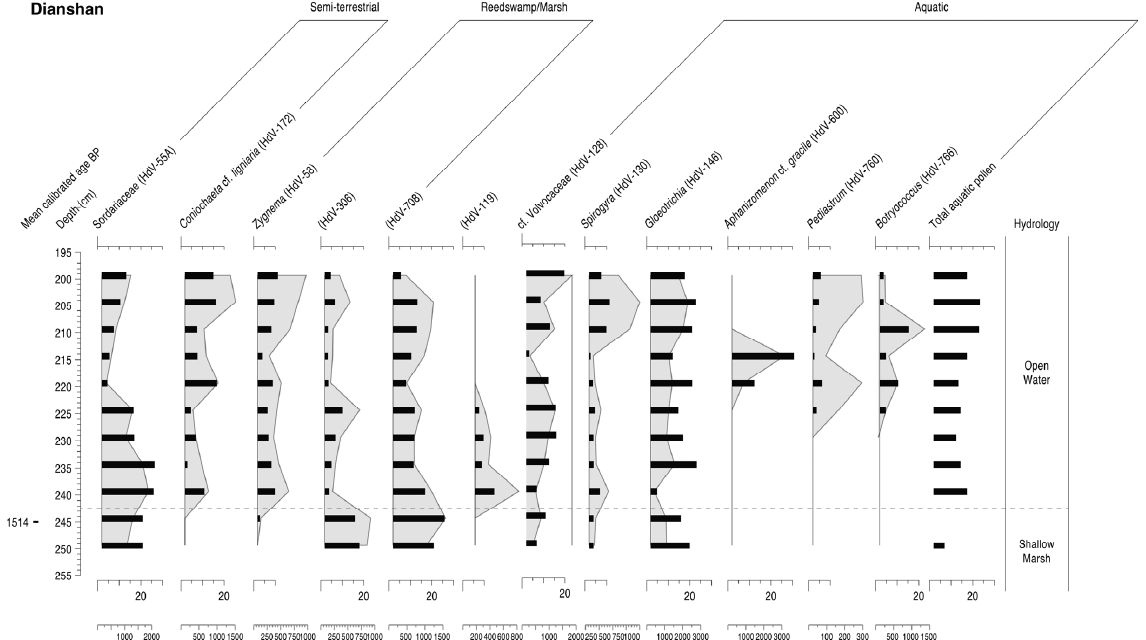
Figure 4. Frequencies of selected NPP taxa (histogram bars calculated as % total NPPs) from Dianshan. A combined aquatic pollen curve is also shown, calculated as percentages of total land pollen. Pollen concentration values for the NPPs are shown as shaded curves (numbers of grains per cc. on the secondary x-axis).